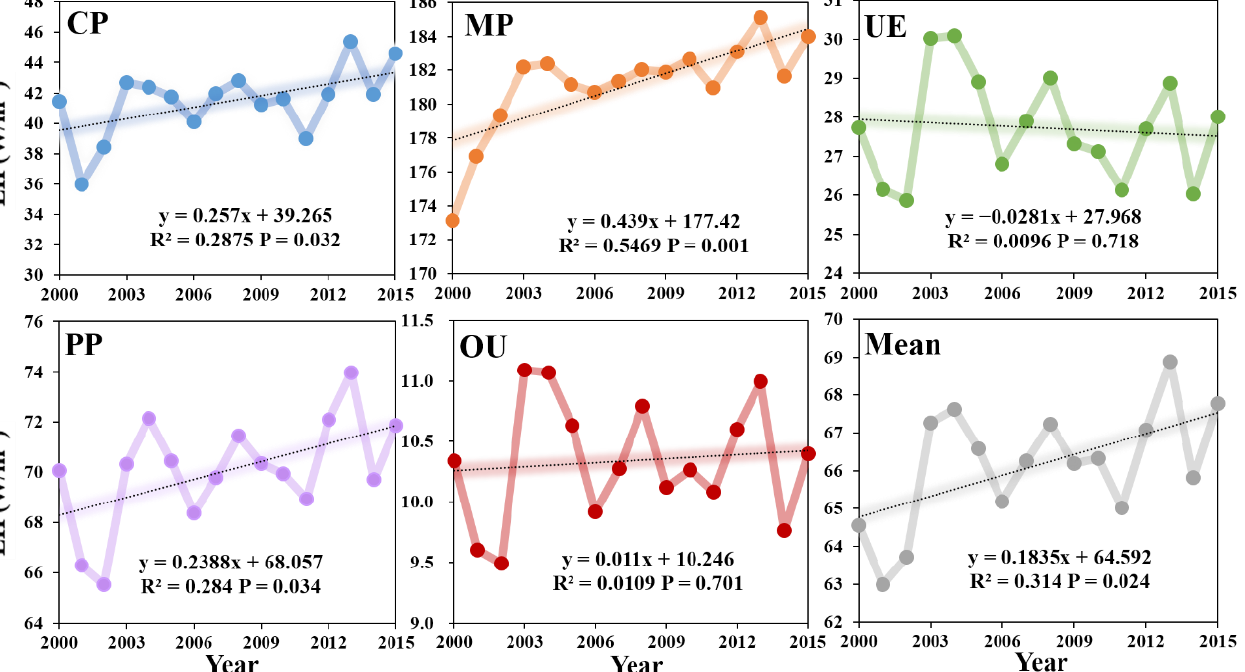
Figure 10. Latent heat flux (LH) trend of different land use types in the Huang-Huai-Hai River Basin from 2000 to